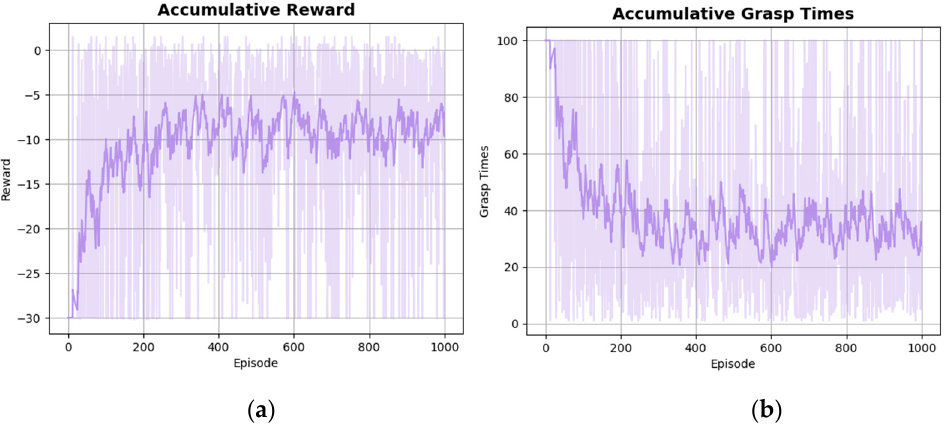
Figure 15. Results of the V-REP robot simulator without combining YOLOv3: ( a ) accumulated reward for each episode; ( b ) number of grasping attempts for each episode. Table 2. Total training time and total number of grasping attempts.